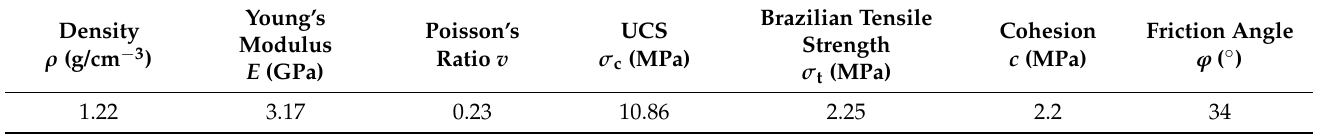
Table 2. Physical and mechanical properties of the model material.